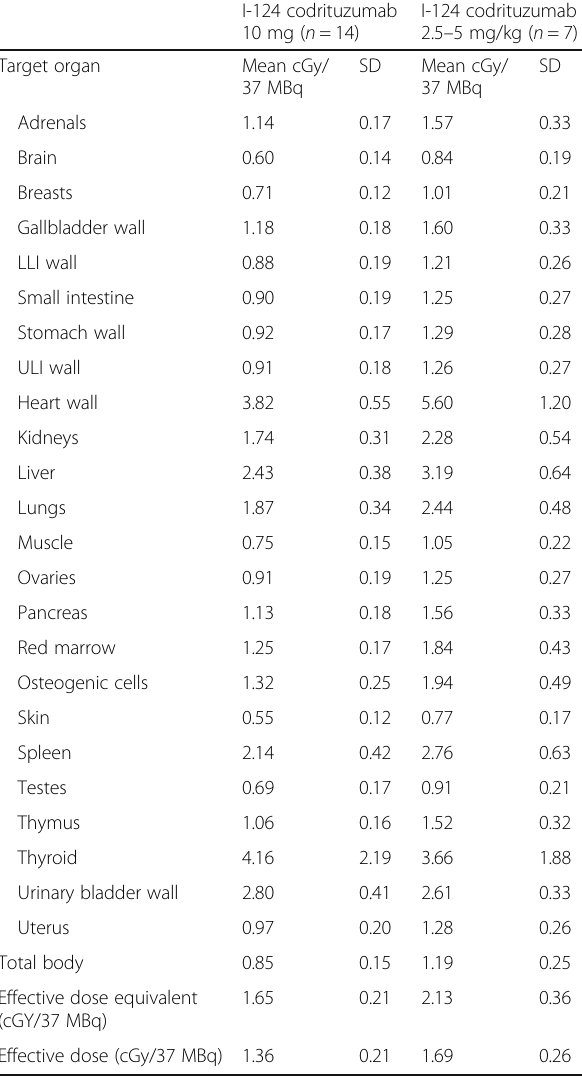
Table 3 I-124 codrituzumab radiation dose